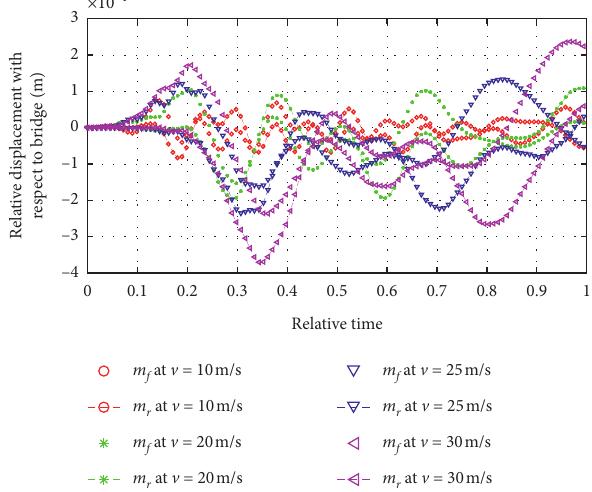
Figure 15: The relative displacement of the front wheel and the rear wheel.